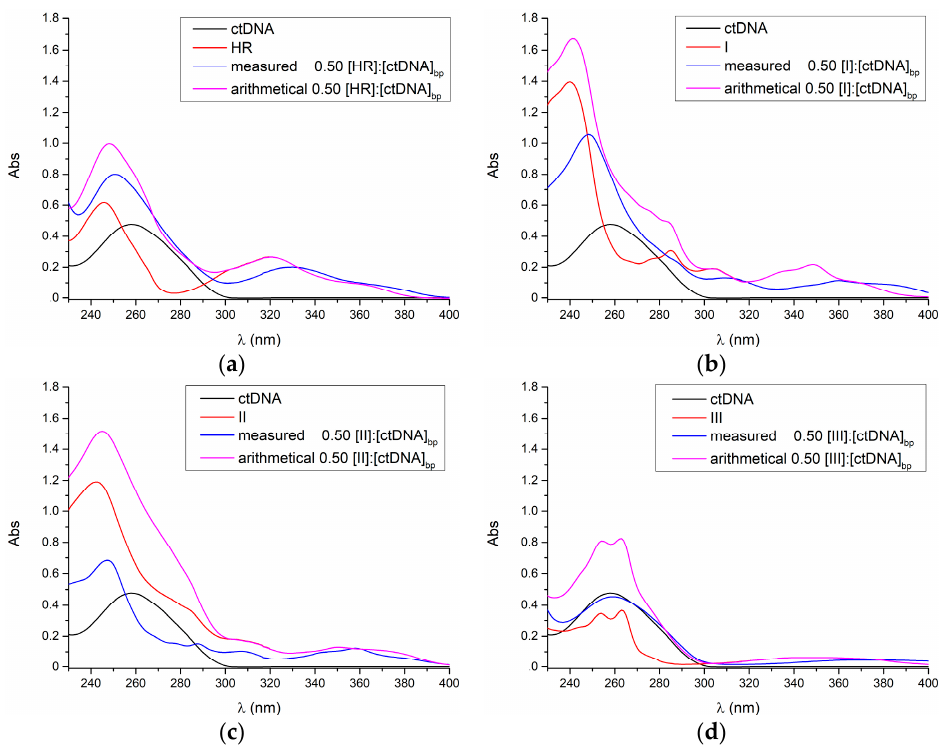
Figure 3. UV absorption spectra of the ctDNA with ( a ) harmine; ( b ) I ; ( c ) II ; and ( d ) III . The arithmetical ligand-ctDNA sum spectra are reported as well.